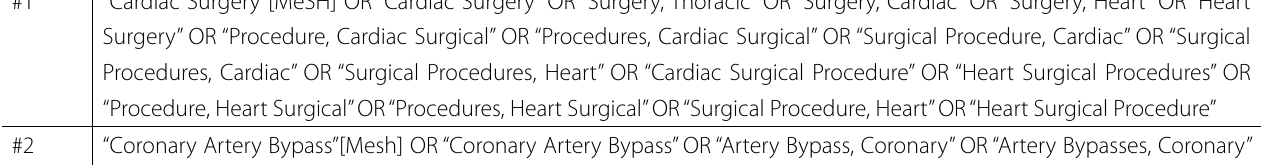
Table 1. Research strategy used on PubMed.